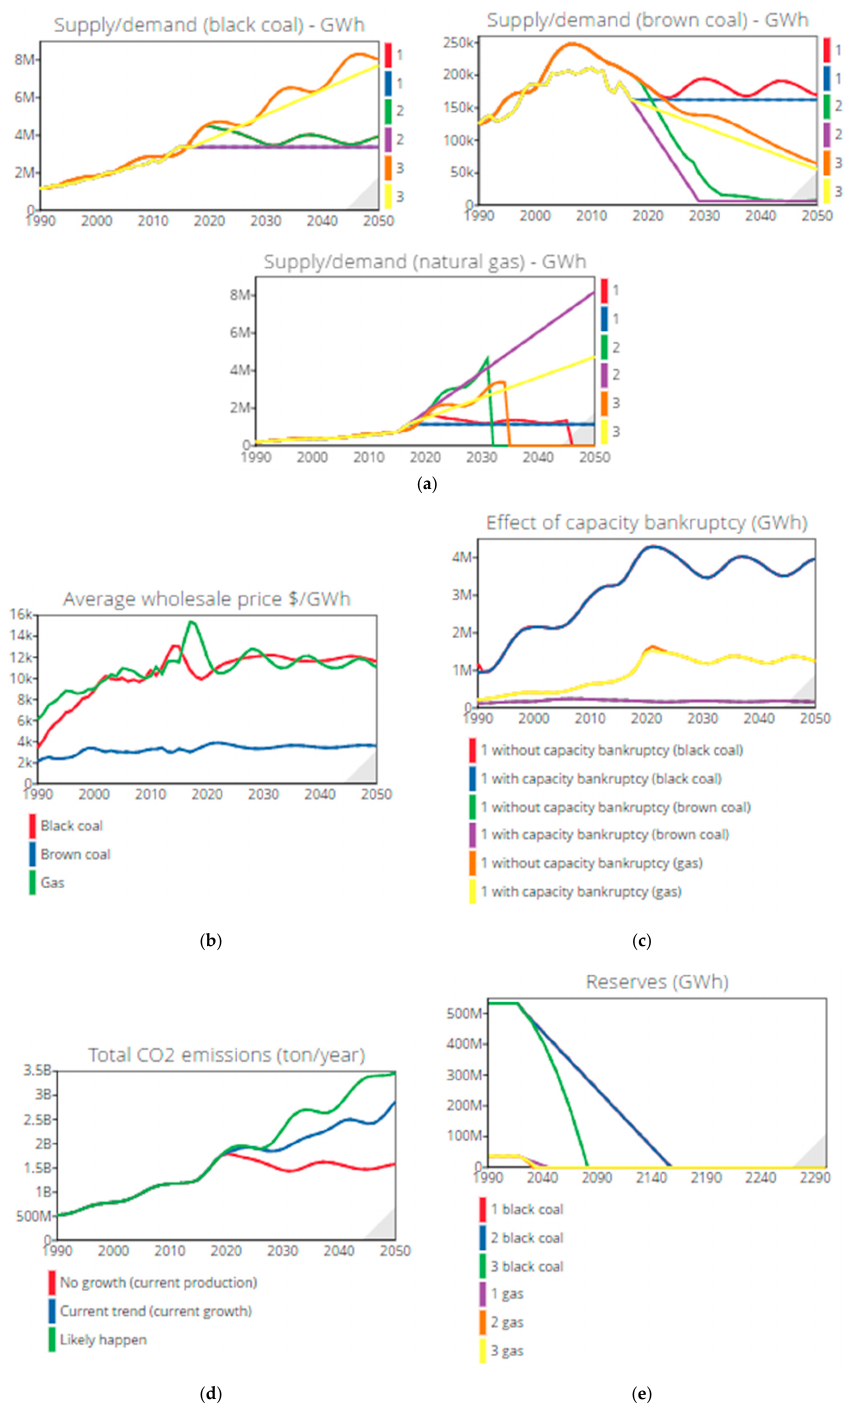
Figure 10. Behaviour over time produced by each development scenario until 2050 for ( a ) energy supply / demand, ( b ) average wholesale price, ( c ) bankruptcy, ( d ) CO 2 emissions and ( e ) reserves. The numbers on each colour represent (1) no growth scenario, (2) base case / current scenario and (3) likely to happen scenario, as described in Table